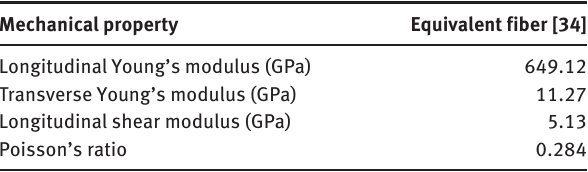
Table 1 Material properties of equivalent fiber ( E = 7.5%). V e